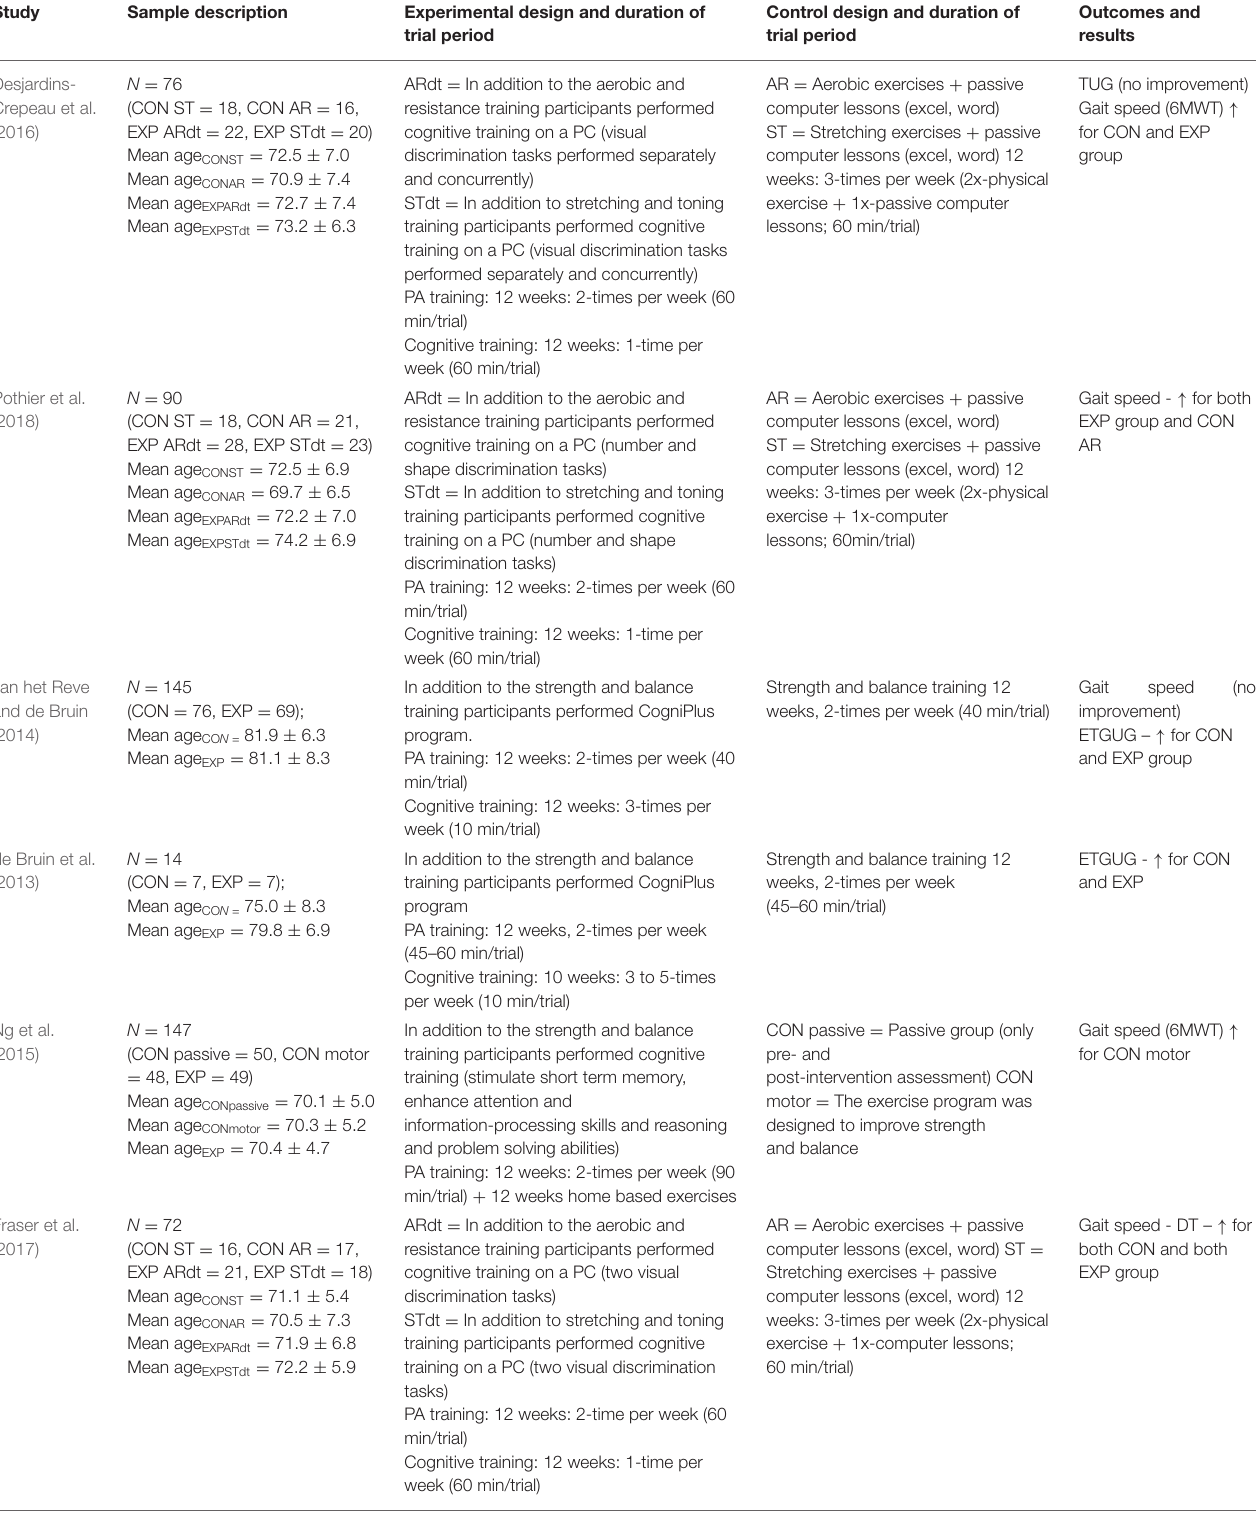
TABLE 3 | Sequential motor-cognitive